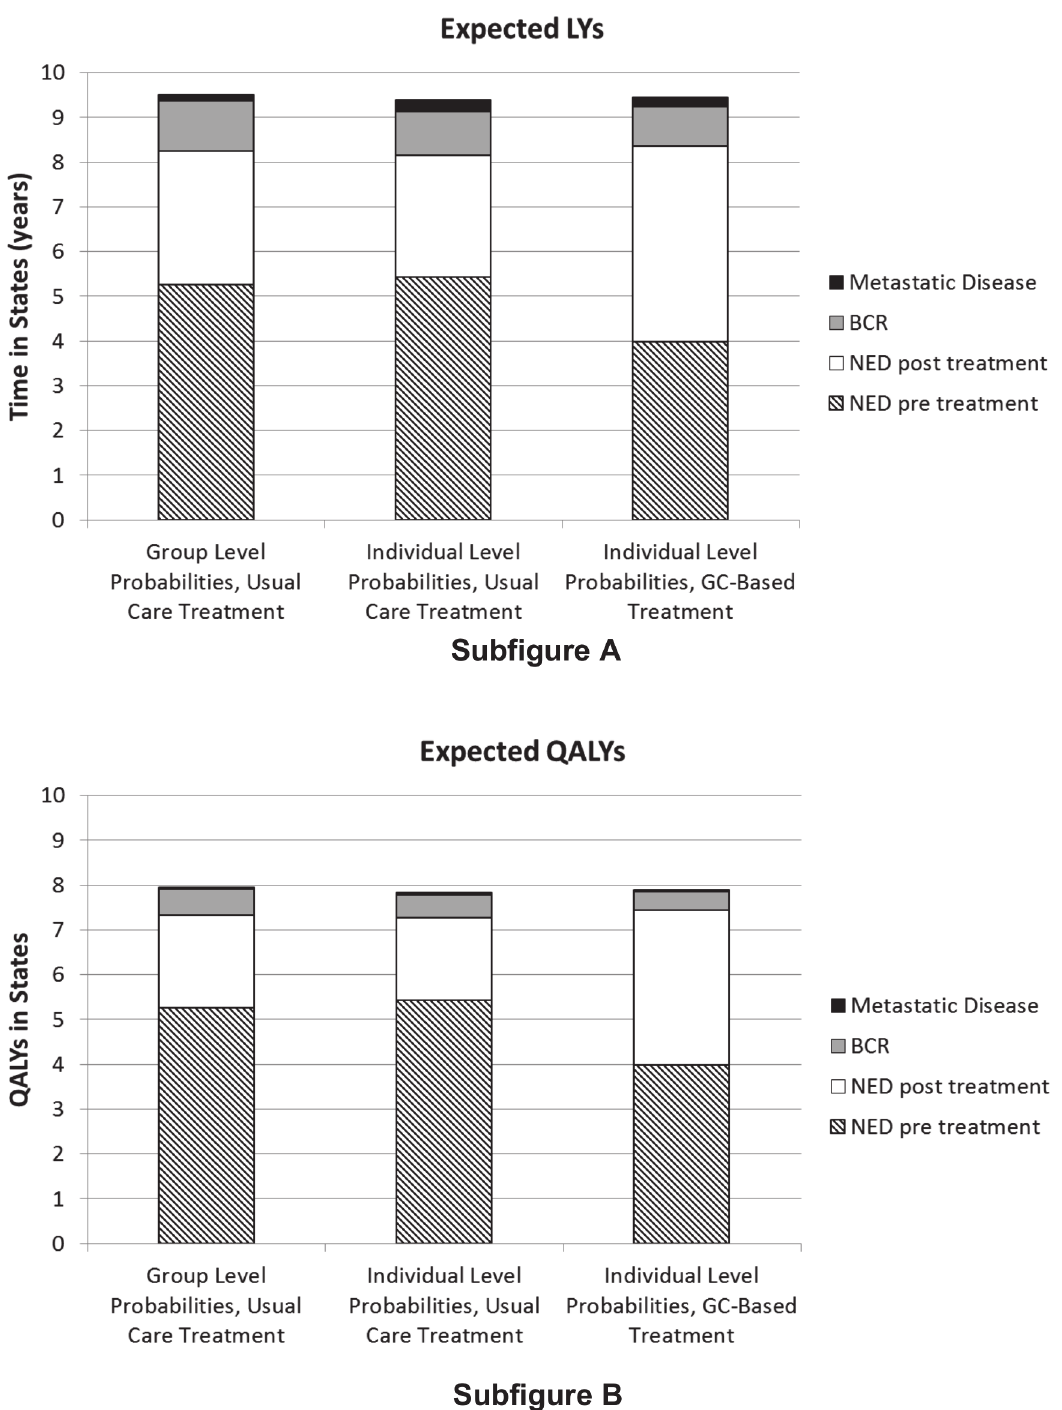
Fig 2. Time in life years (LYs) in states (Subfigure A), and quality-adjusted life years (QALYs) in states (Subfigure B) for the Mayo Clinic Cohort. GC-based treatment refers to treatment decisions made based upon the genomic risk classifier assay. BCR = biochemical recurrence; NED = no evidence of disease; GC = genomic